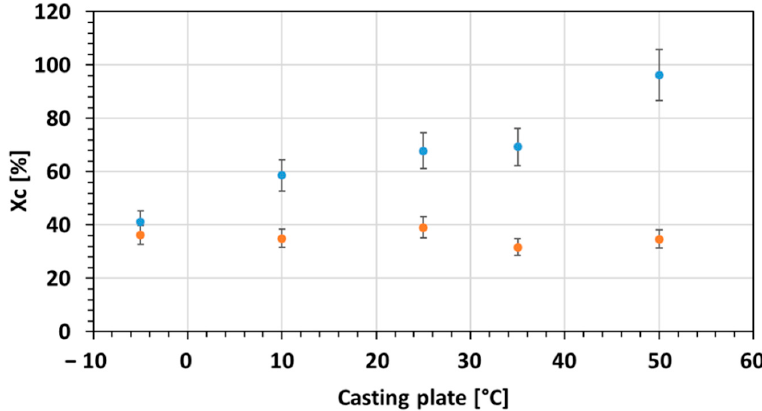
Figure 7. Crystallinity degree of neat PEBAX (Blue) and MMMs (Orange) according to the casting plate temperature (PA phase).